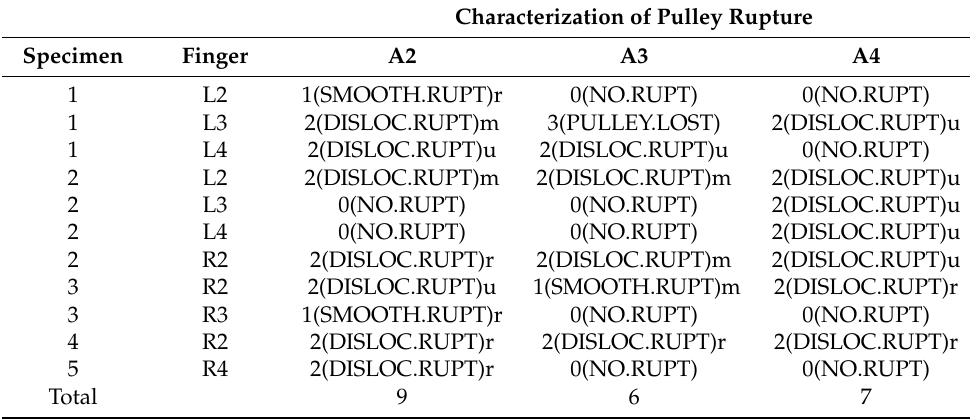
Table 1. Macroscopic distribution of finger flexor pulley A2, A3, and A4 ruptures at the index finger (2), middle finger (3), and ring finger (4) separated by side (L—left; R—right) and characterized by rupture morphology (0 (NO.RUPT)—intact finger flexor pulley, 1 (SMOOTH.RUPT)—rupture with stump visible adjacent to the flexor tendon, 2 (DISLOC.RUPT)—rupture with intercalation (dislo- cation of the pulley stump between the flexor tendon and finger phalanx), and 3 (PULLEY.LOST)— rupture without visible stump; side of finger flexor pulley rupture, r—radial, u—ulnar, m—middle).